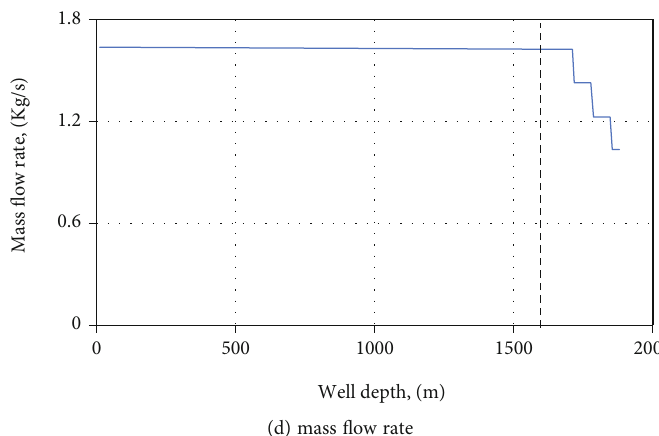
Figure 14: The (a) steam pressure, (b) steam temperature, (c) steam quality and (d) mass fl ow rate of steam along the wellbore of Well XH27.